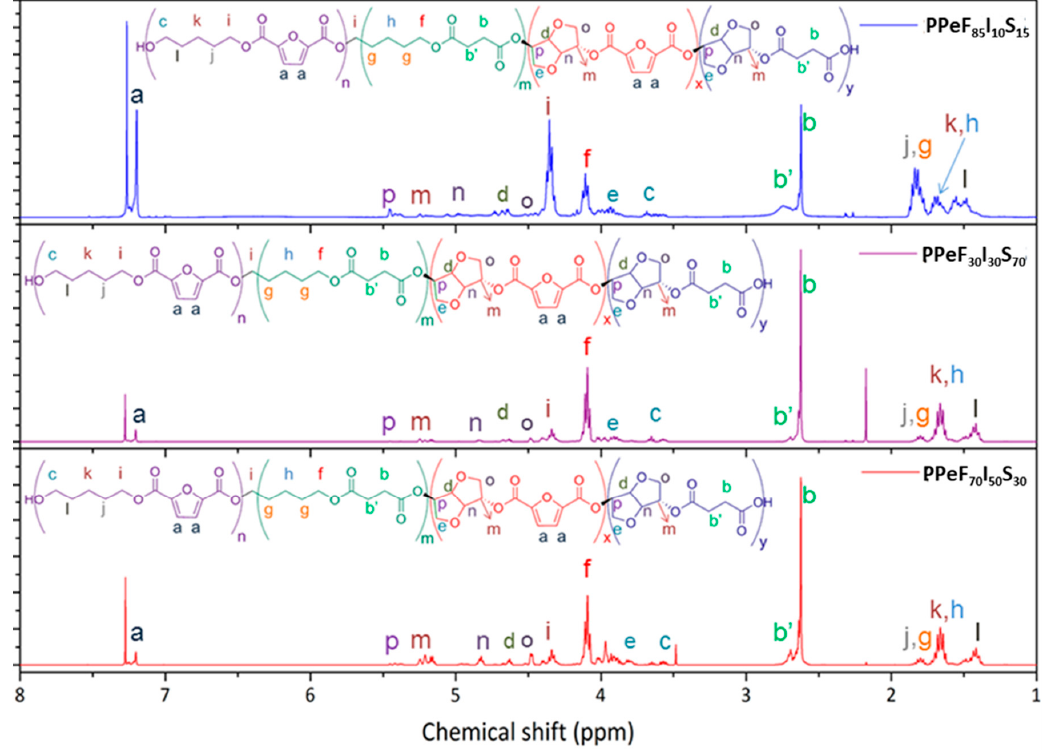
Figure 2. 1 H NMR spectra of PPeF 85 I 10 S 15 , PPeF 30 I 30 S 70 , and PPeF 70 I 50 S 30 . The mol % isosorbide increases from top to bottom.